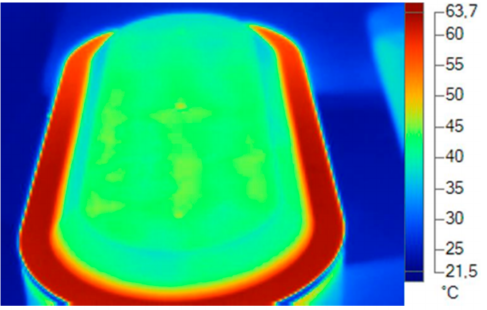
Figure 22. Thermal data of the diffuser. Green zone: plastic emissivity 0.92. Source: Software SmartView 4.1 Fluke.